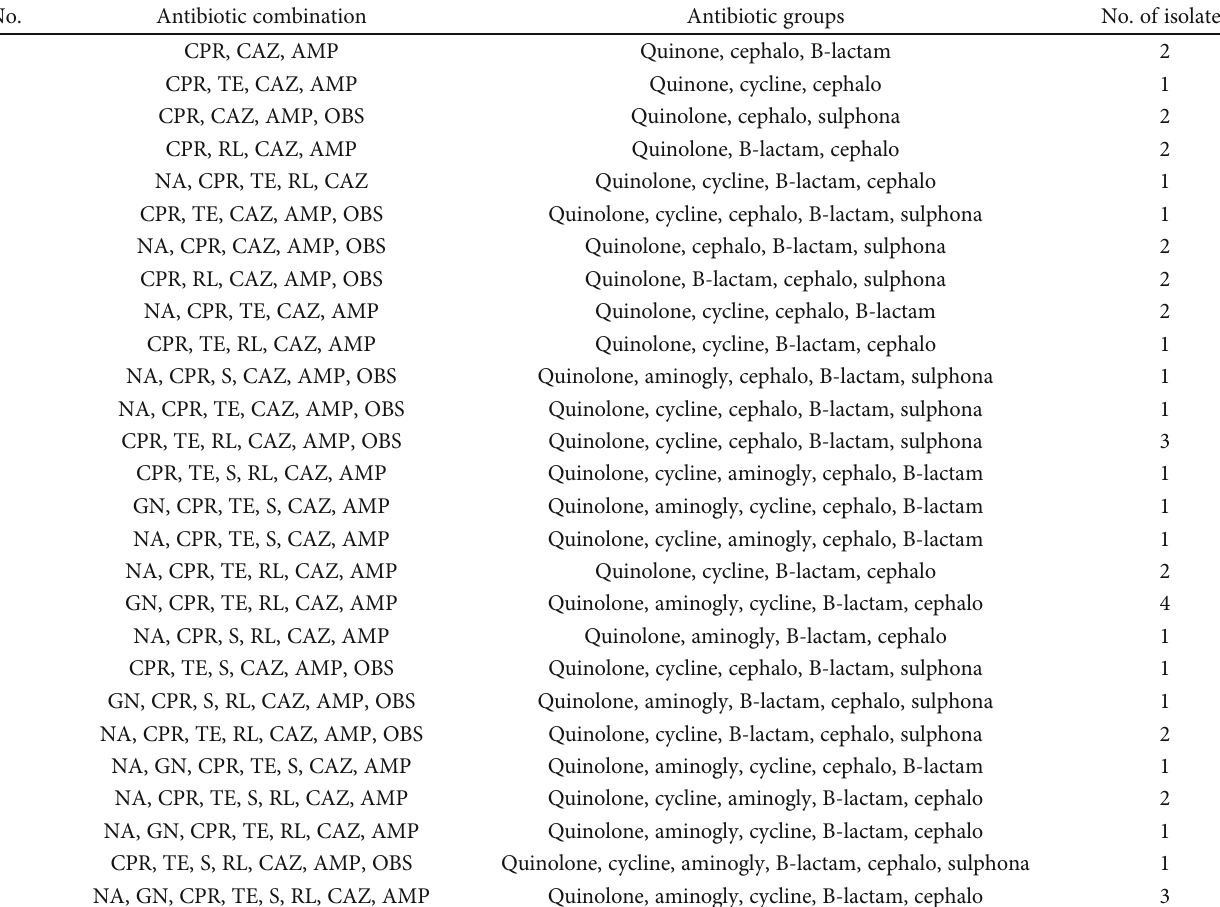
Table 5: Multidrug resistance pattern of Salmonella species isolated from intestinal contents and ready-to-eat chicken gizzards. No.